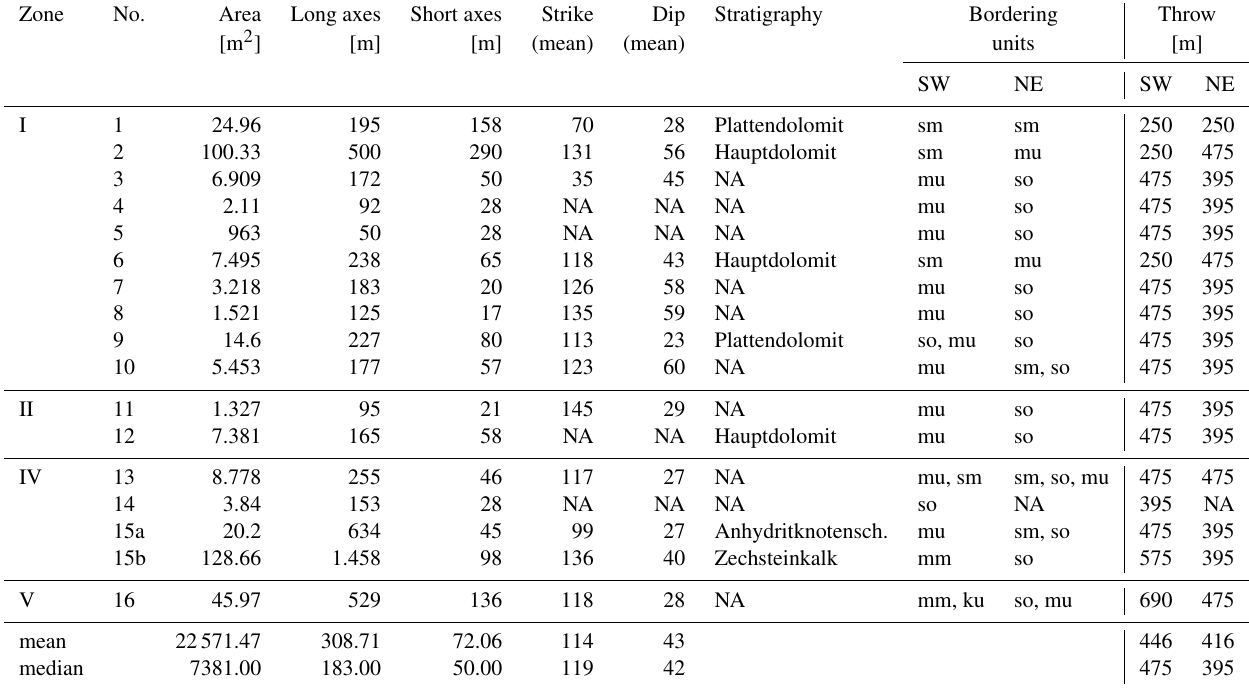
Table 1. Statistical compilation of the Zechstein slivers. The values for vertical offset are calculated based on thicknesses given by Motzka- Noering et al.